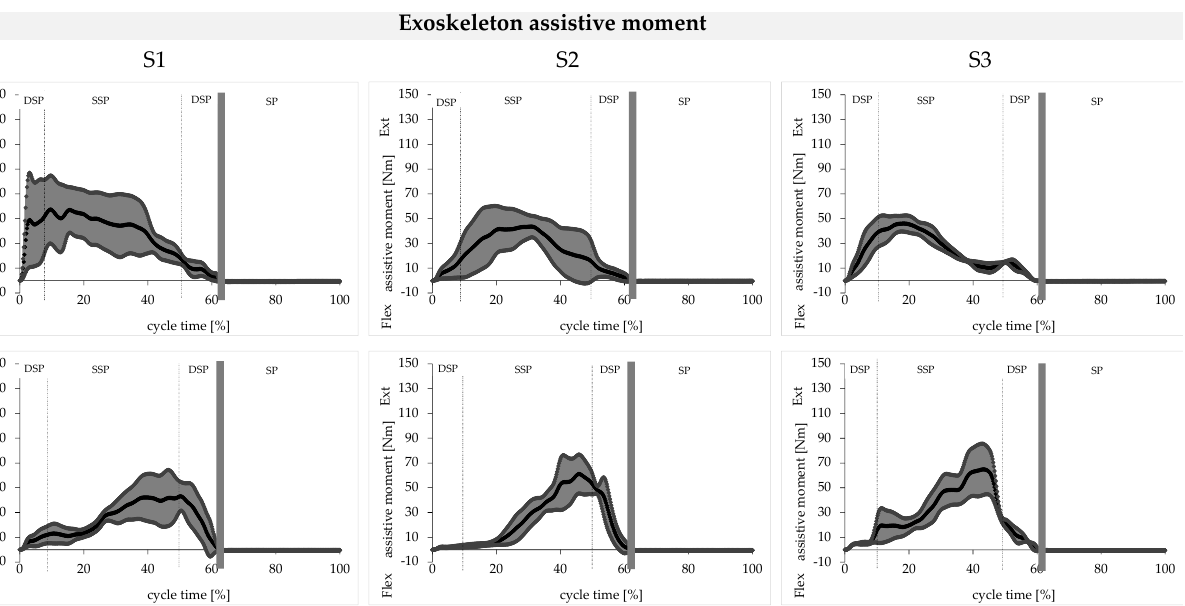
Figure 5. Exoskeleton assistive moment in the knee joint to assist knee extension for Subject 1 ( left ), Subject 2 ( middle ), and Subject 3 ( right ); DSP = double stance phase, SSP = single stance phase, SP = swing